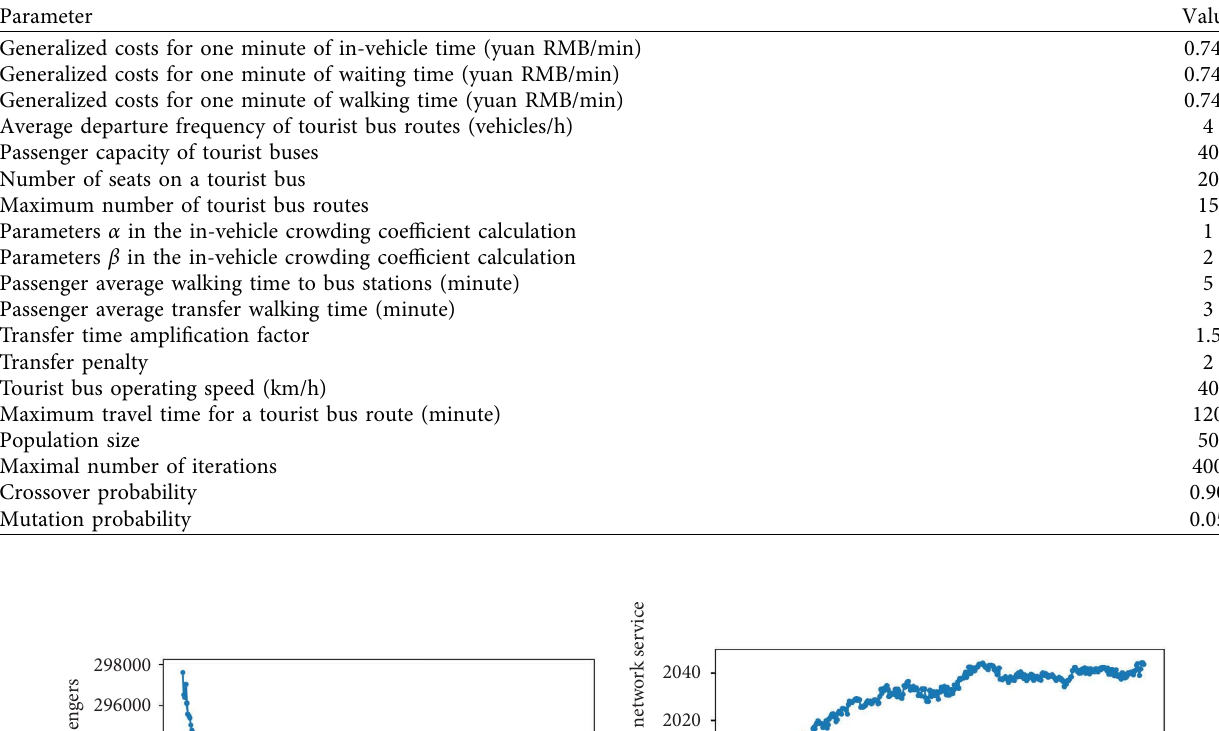
Table 5: Major parameters for the numerical example of the Lishui district.